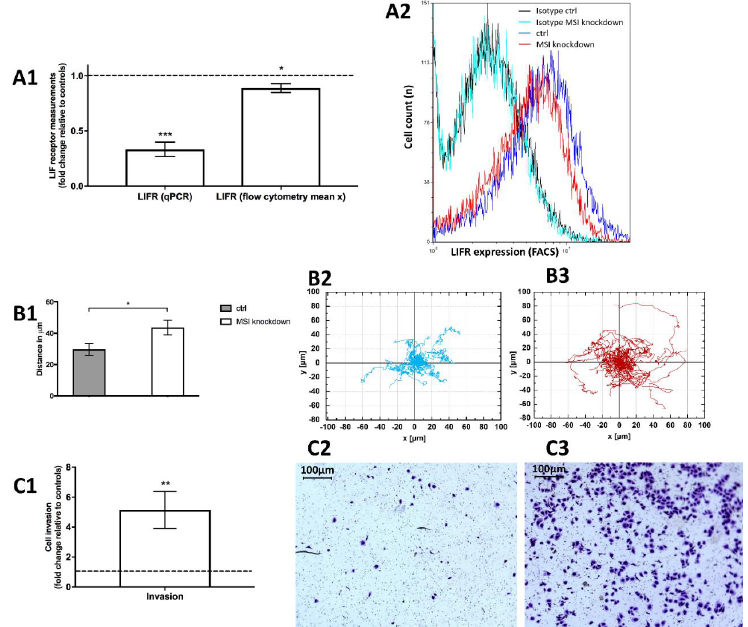
Figure 5. Influence of Musashi ( MSI ) RNA-binding protein knockdown on leukemia inhibitory factor receptor (LIFR) expression, cell migration and invasiveness in triple-negative MDA-MB-231 cells. 5A1 : The LIFR is downregulated in MSI knockdown cells both in qPCR and in flow cytometric measurements (mean x being the mean fluorescence intensity of the respective sample) with a representative histogram including respective isotypes (unspecific antibodies of the same subclass that show low fluorescence intensity and no discernible difference between samples, thus indicating that changes are due to specific antibody binding) in 5A2 (on a logarithmic x scale). 5B1 : Cell migration distance increases subsequent to MSI knockdown compared to controls (ctrl): Cell tracking of control cells ( 5B2 ) and MSI knockdown cells ( 5B3 ) demonstrates higher motility in the latter. 5C1 : Cell invasiveness is strongly enhanced after MSI silencing with representative pictures of invasive cells for controls ( 5C2 ) and MSI knockdown cells ( 5C3 ). Respective staining was performed with 1% Toluidine blue. Cells were transfected with a control siRNA and MSI-1 and MSI-2 siRNA, respectively, as detailed in the Methods section (at least n = 3, * p < 0.05, ** p < 0.01, *** p < 0.001, error bars indicate s.e.m.).